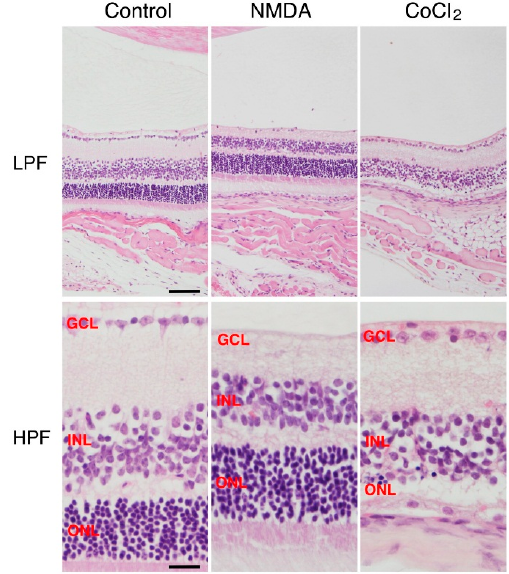
Figure 1. Retinal cell degeneration induced by NMDA and CoCl 2 in mice. Representative photographs Retinal cell degeneration induced by NMDA and CoCl 2 in mice.